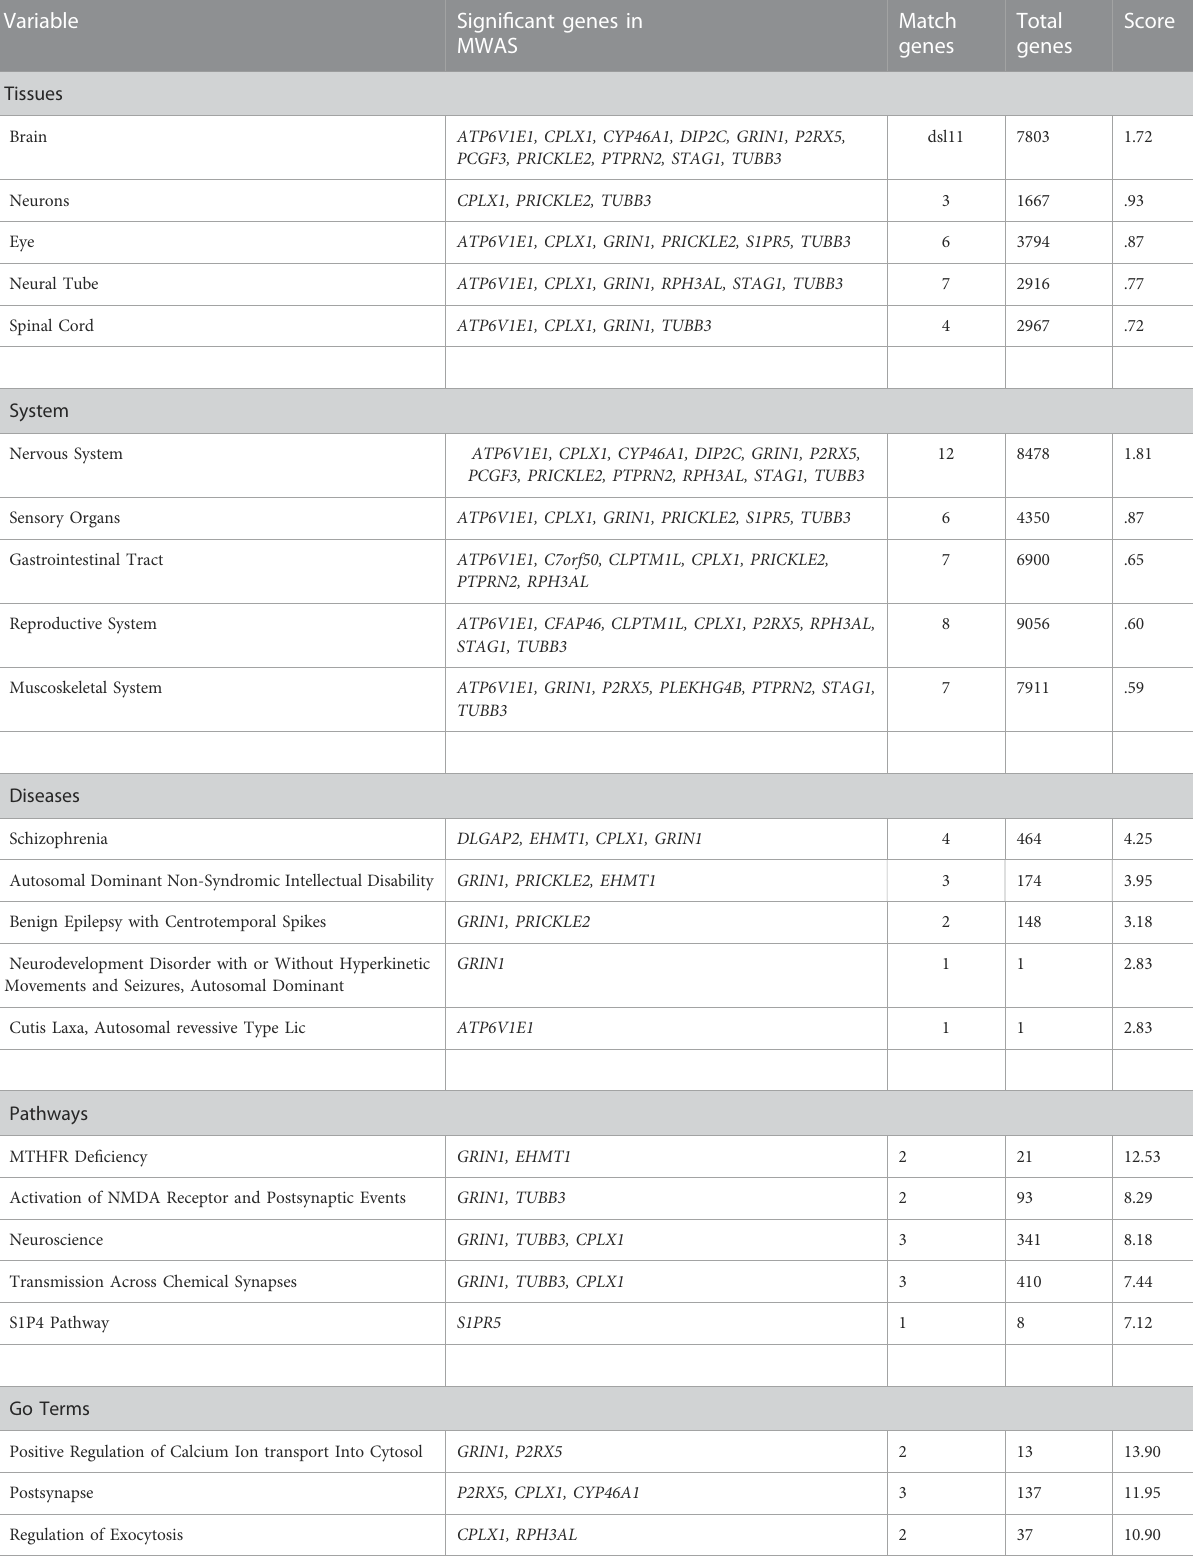
TABLE 3 Gene sets analysis for DMPs and